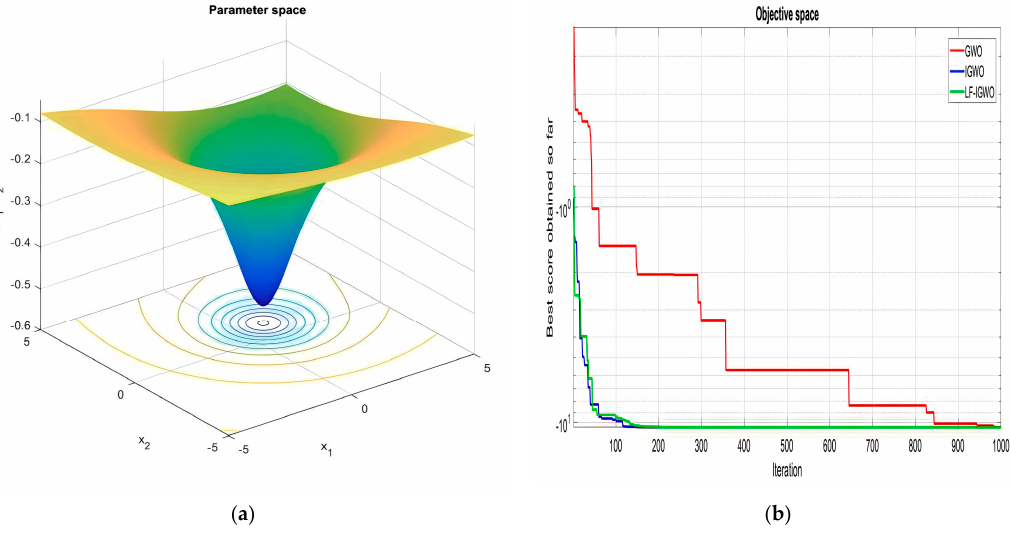
Figure 25. ( a ) Search space for fi xed dimensional function F23 ( b ) Comparison of convergence curve for F23.